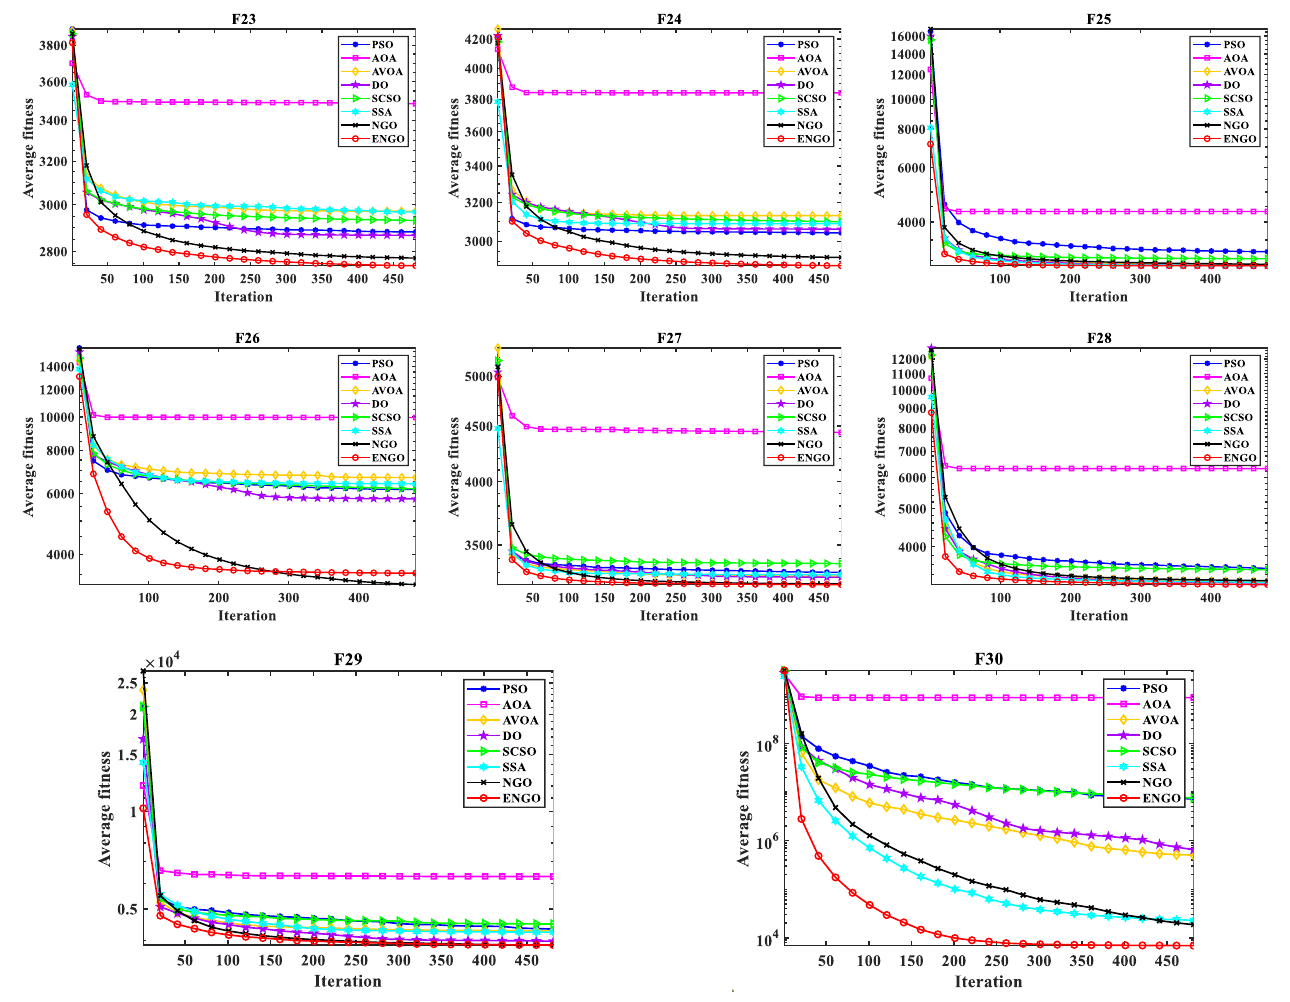
Figure 6. The average convergence curves of different algorithms on CEC2017.